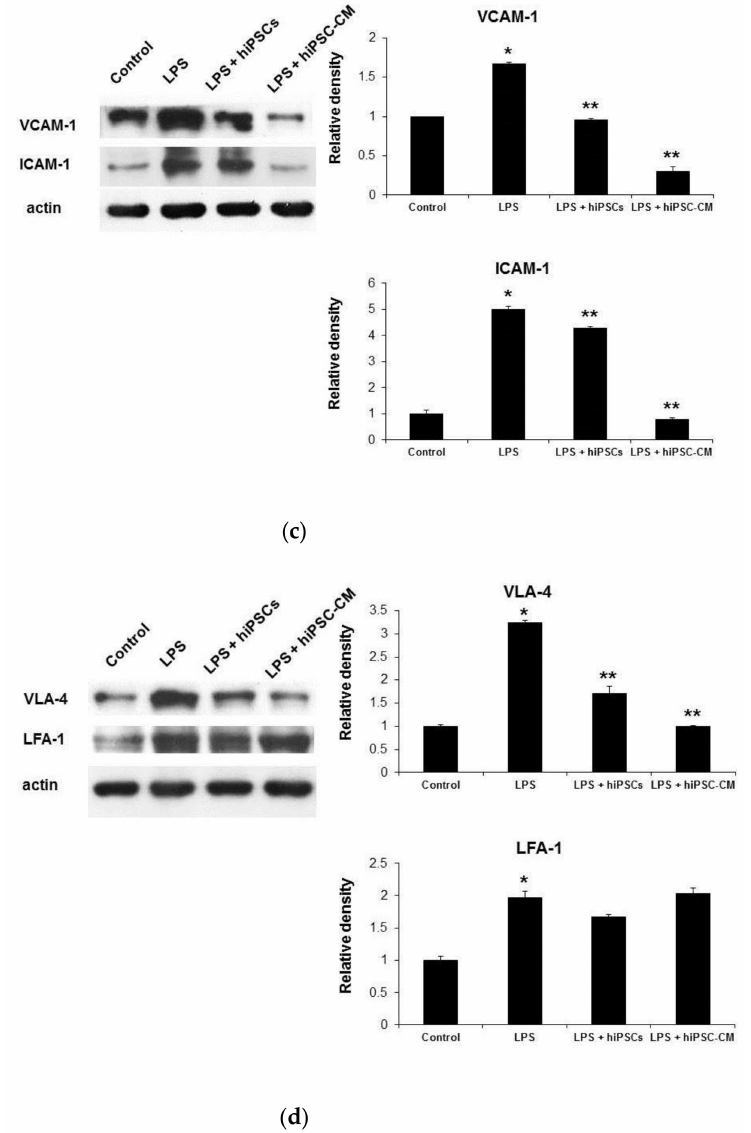
Figure 4. Administration of hiPSCs or hiPSC-CM reduced human neutrophils (D-HL-60 cells) adhering to human endothelial cells (HUVECs) and inhibited the TEM of neutrophils induced by LPS. Administration of hiPSCs or hiPSC-CM reduced the VCAM-1 expression induced by LPS in HUVEC and VLA-4 induced by LPS in D-HL-60 cells. ( a ) The D-HL-60 cell/HUVEC adhesion assay showed that D-HL-60 cells adhering to HUVECs significantly increased after administering LPS compared to the control. In contrast, the D-HL-60 cell/HUVEC adhesion induced by LPS was reduced by the intravenous delivery of miPSCs or miPSC-CM. ( b ) Similarly, the D-HL-60 cell/HUVEC transmigration assay showed that D-HL-60 cell TEM significantly increased after administering LPS and was reduced by the intravenous delivery of miPSCs or miPSC-CM. ( c ) Western blot assays showed that the expression of VCAM-1 and ICAM-1 in HUVECs significantly increased after administering LPS and was reduced by the intravenous delivery of miPSCs or miPSC-CM. ( d ) Western blot assays showed that the expression of VLA-4 in D-HL-60 cells significantly increased after administering LPS and was reduced by the intravenous delivery of miPSCs or miPSC-CM. However, the increased expression of LFA-1 in D-HL-60 cells induced by LPS was not reduced by miPSCs or miPSC-CM. Data are presented as the mean ± SD. * p < 0.05, compared to control mice; ** p < 0.05, compared to LPS-induced ALI mice; n = 6 per